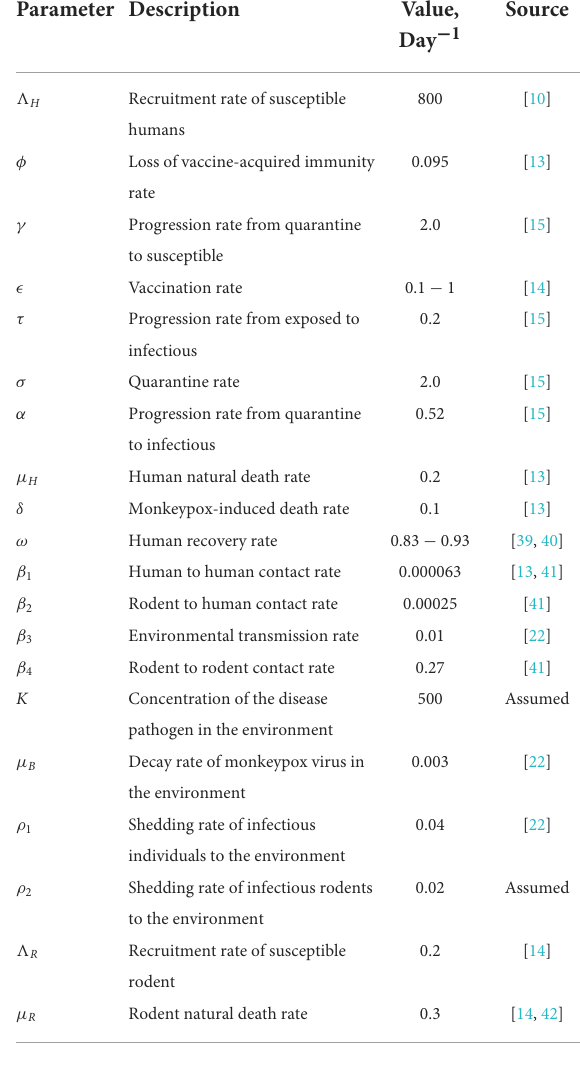
TABLE 1 Description of state variables. TABLE 2 Parameter estimation for numerical